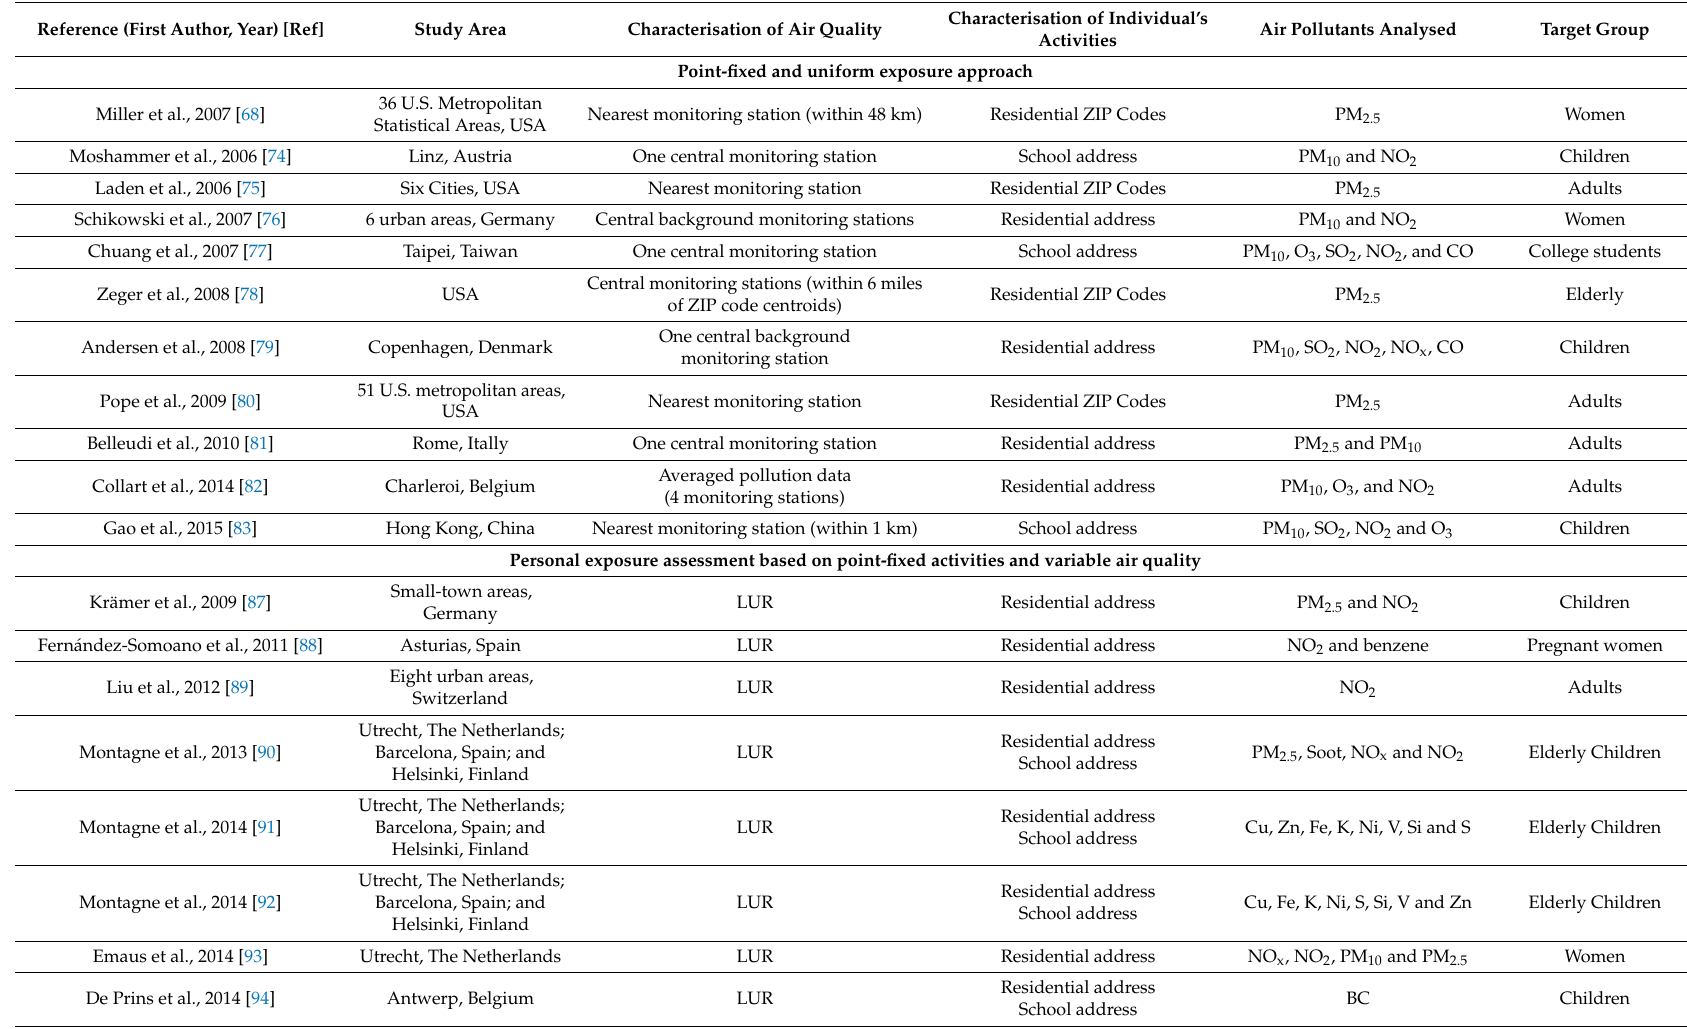
Table 1. Main characteristics of studies included in the review organized under the new classification